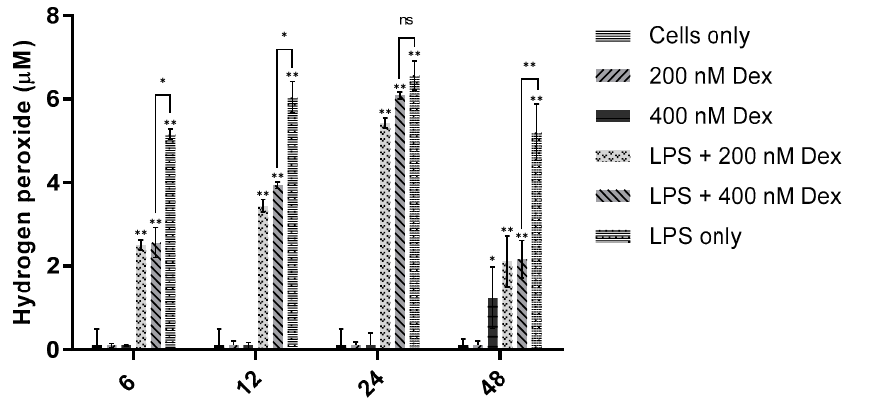
Figure 10. Effect of dexamethasone on H 2 O 2 production in RAW 264.7 cells. Cells received 200 ng/mL LPS and/or 200 nM or 400 nM Dex in each well. Cells were incubated for 6, 12, 24, or 48 h following addition of LPS and/or Dex. Probe sensitivity: 11.0 pA/µM; R 2 , 0.9997. One-way ANOVA ( n = 14, p < 0.001) and the Tukey–Kramer test ( n = 14, * p < 0.05, ** p < 0.001) were used to assess statistical significance.